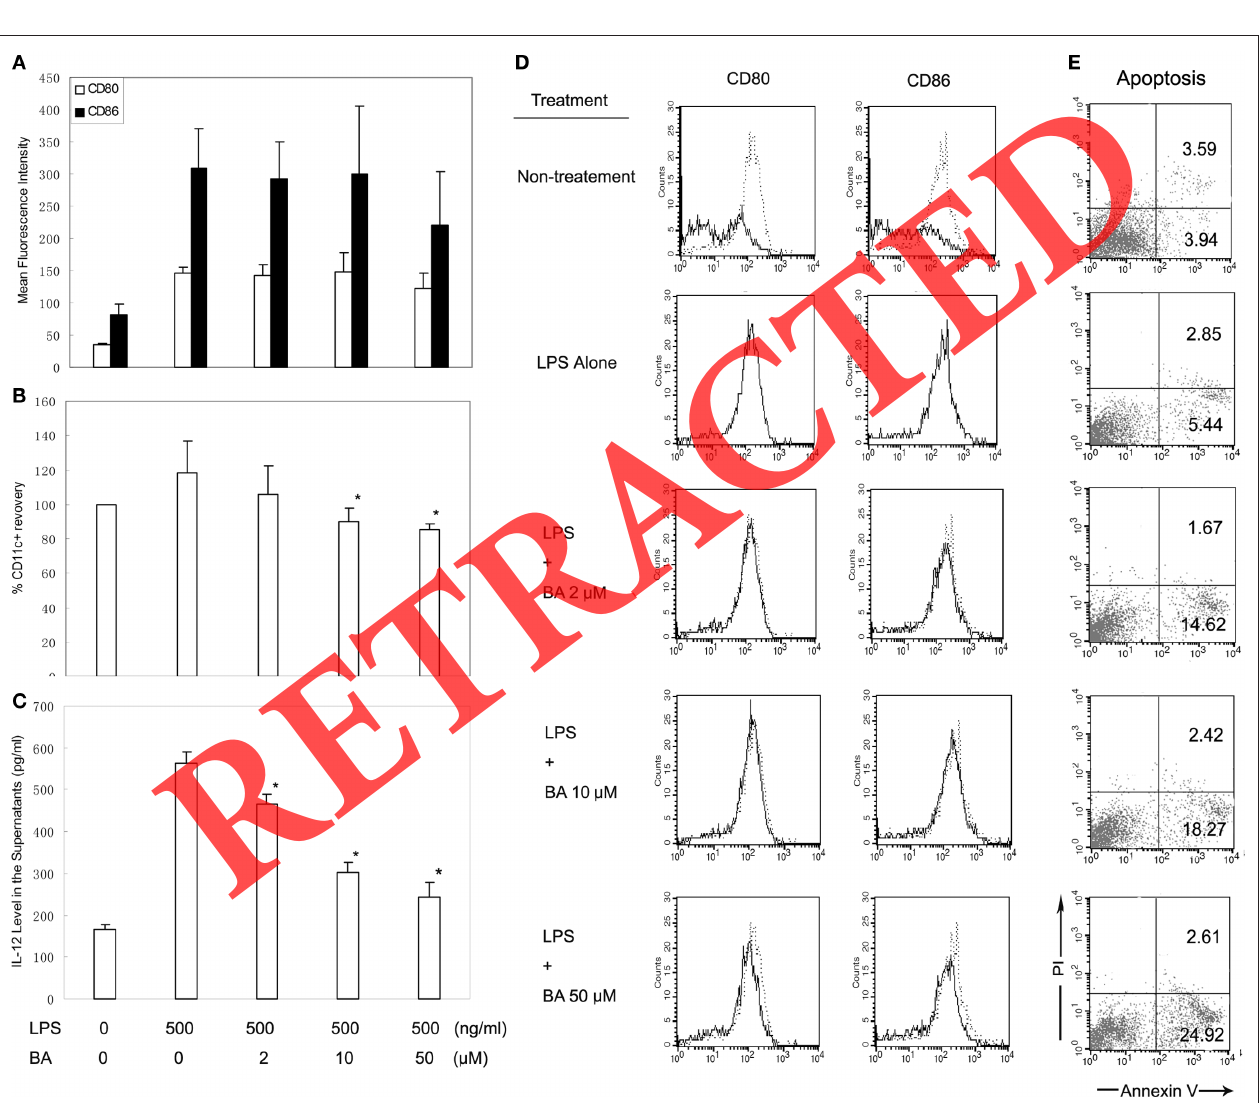
(A–C) Results were obtained from three independent experiments and presented as mean values ( ± SD). * p < 0.05 vs. LPS alone control by Student’s t -test. (D) Representative histograms showing CD80 and CD86 expression on day-6 BMDCs from three independent experiments. (e) The percentage of apoptosis in day-6 BMDCs determined by FACS, using annexin V/PI staining. The results are representative of three